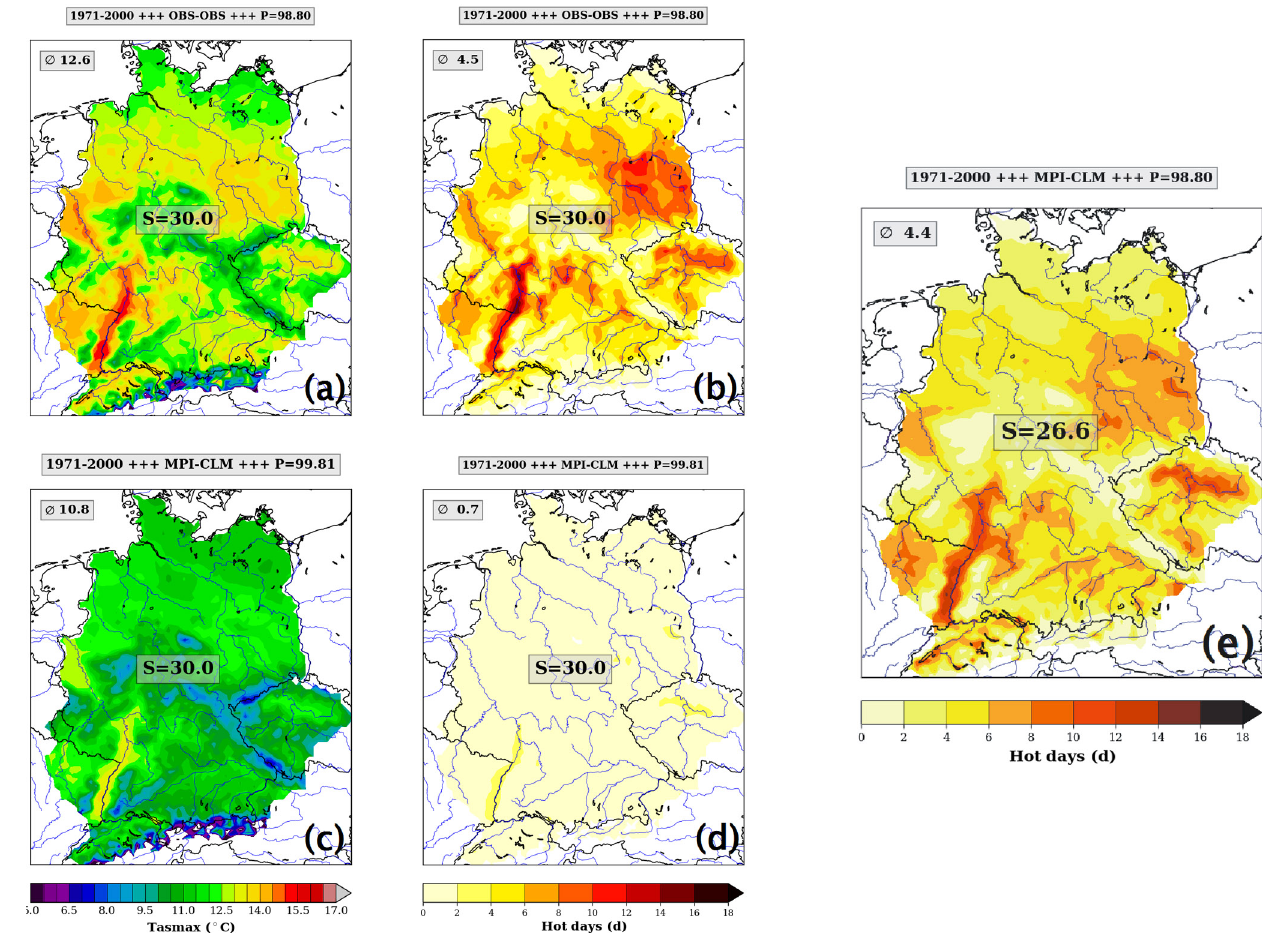
Figure 2. Work flow of the threshold adjustment approach, indicated by (a) – (d) . First row: tasmax (OBS) → su30 (OBS). Second row: → tasmax (RCM) → su30 (RCM). Larger graph (e) : Resulting map for su26 . 6 (RCM). The box in the upper left corner of each subfigure indicates the areal average ( ∅ ) for the ReKliEs-De domain. The box in the center of each subfigure shows the temperature threshold [ ◦ C] used to determine the number of hot days. The percentile of the temperature threshold is given in the right-hand side of the bar over the figure. This bar also shows on its left-hand side which period is used and the text in its center denotes if observations (OBS) or a GCM-RCM combination (in this example: MPI-CLM) is